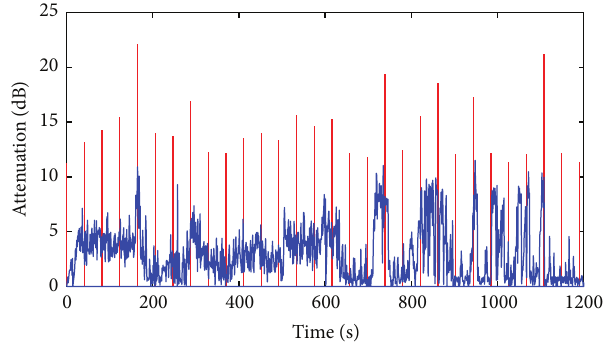
Figure 20: Total attenuation (PAs) + rain versus time series synthe-